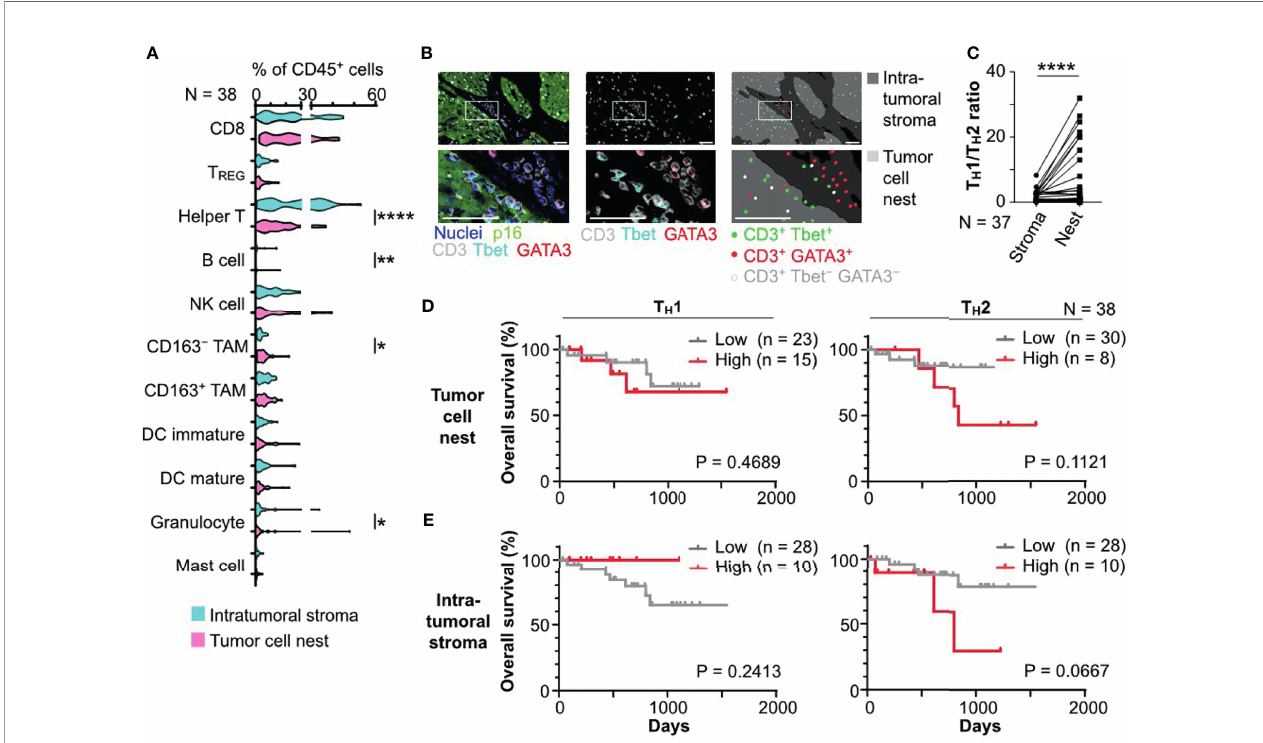
FIGURE 2 | Tissue segmentation elucidates spatially differential phenotypes of immune cell in fi ltrates in HNSCC. (A) Percentages of immune cell lineages of total CD45 + cells were shown, comparing the intratumoral stroma and tumor cell nest regions. (B) A series of images from an HPV-positive HNSCC tissue section showing differential distribution of Tbet + CD3 + (T H 1) and GATA3 + CD3 + (T H 2) cells. Left and middle panels show multiplex IHC images with color annotations. Right panels depict cell identi fi cation and location. Boxes represent magni fi ed areas below. Scale bars = 50 m m (C) Ratios of T H 1 to T H 2, comparing the intratumoral stroma and tumor cell nests, are shown. One case was excluded due to the absence of T H 2. Statistical differences in (A) and (C) were determined via Wilcoxon signed rank tests, with *p < 0.05, **p < 0.01, and ****p < 0.0001. (D, E) Kaplan – Meier analyses of overall survival of oropharyngeal SCC (N = 38) strati fi ed by cell densities of T H 1 or T H 2 in fi ltrated in tumor cell nests (D) and the intratumoral stroma regions (E) (cutoff = mean). Statistical signi fi cance was determined using the log- rank